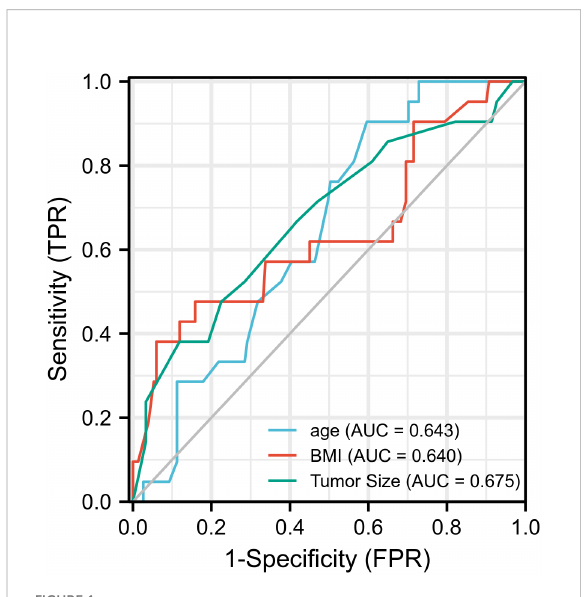
FIGURE 1 Prognostic value validation of age ≥ 50, BMI > 28.4, tumor size ≤ 10 mm by using ROC